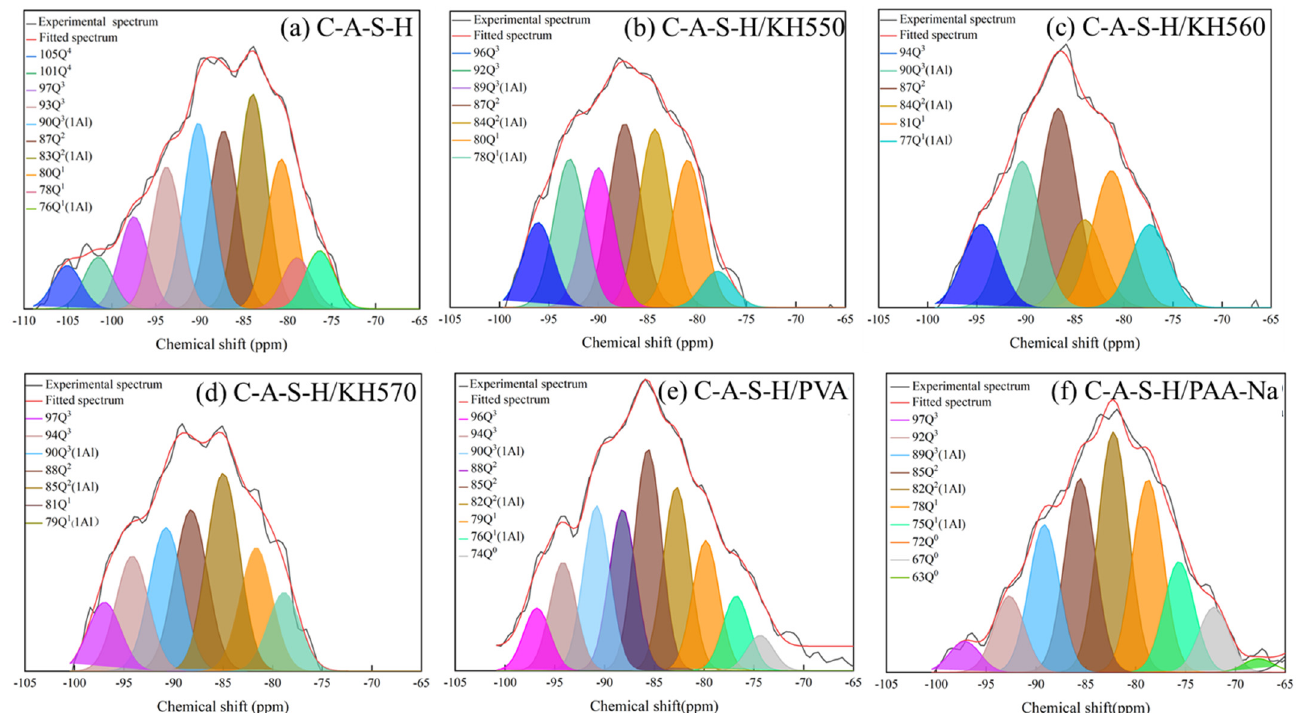
Figure 18. 29 Si NMR spectra for ( a ) C ‐ A ‐ S ‐ H; ( b ) C ‐ A ‐ S ‐ H/KH570; ( c ) C ‐ A ‐ S ‐ H/KH570; ( d ) C ‐ A ‐ S ‐ H/KH570; ( e ) C ‐ A ‐ S ‐ H/PVA; ( f ) C ‐ A ‐ S ‐ H/PAA ‐ Na. Table 6. 29 Si MAS NMR parameters for C ‐ A ‐ S ‐ H nanocomposites.